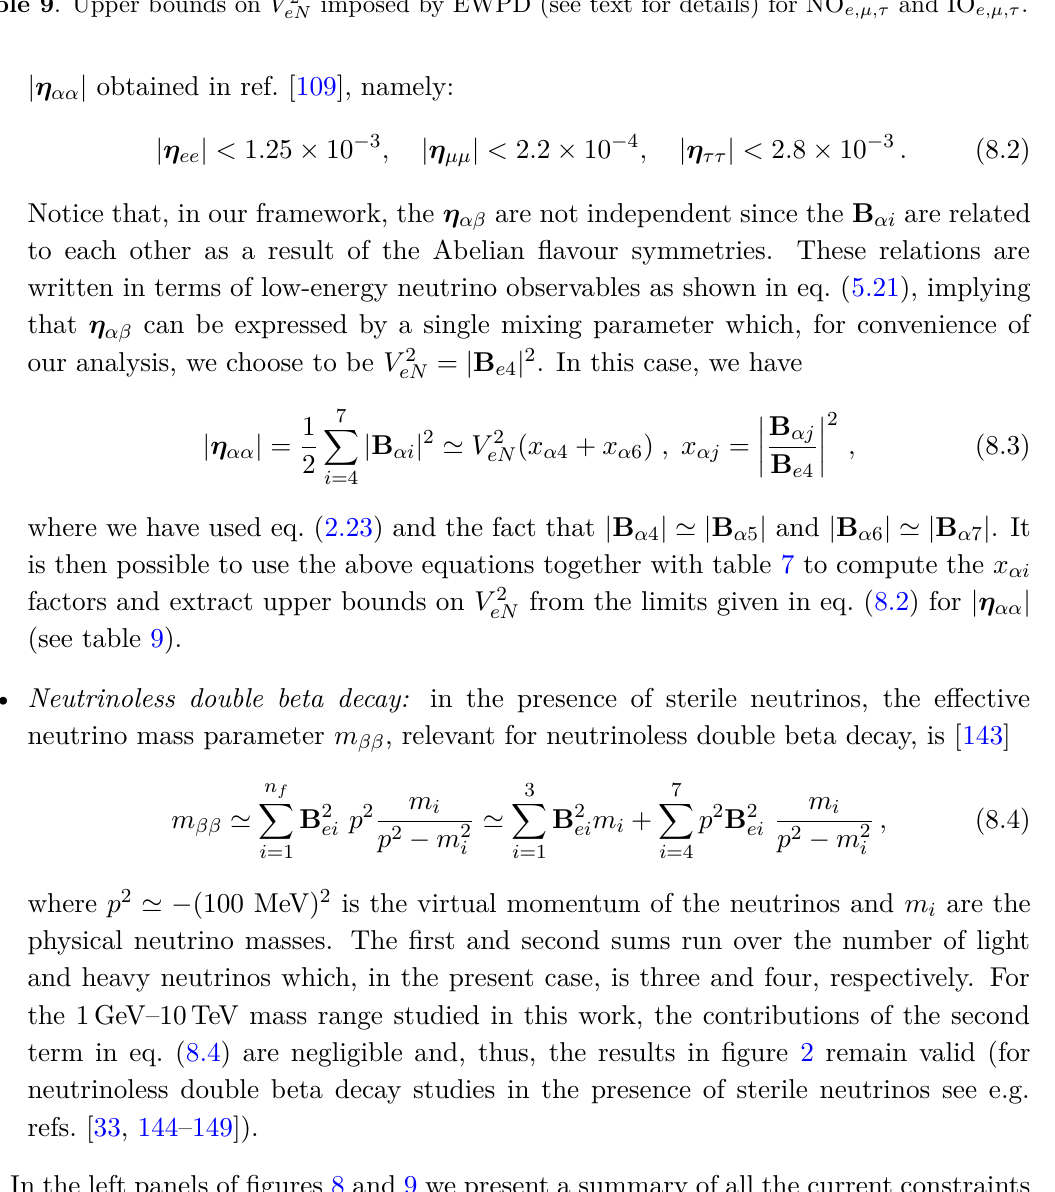
and IO . e,µ,τ e,µ,τ